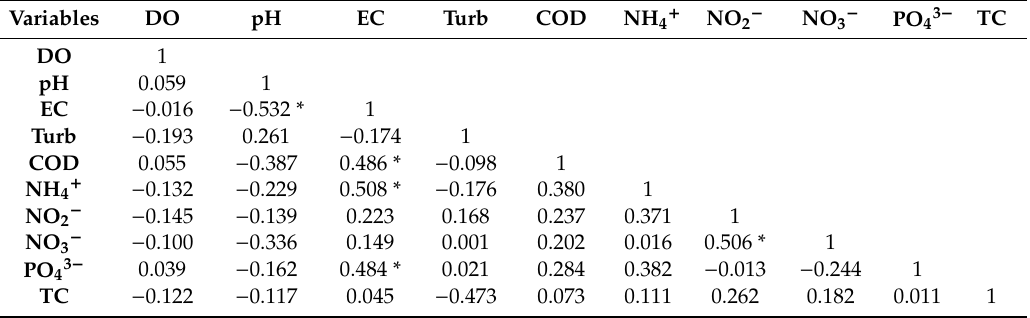
Table 3. Correlation matrices in the wet season using Spearman rank order.